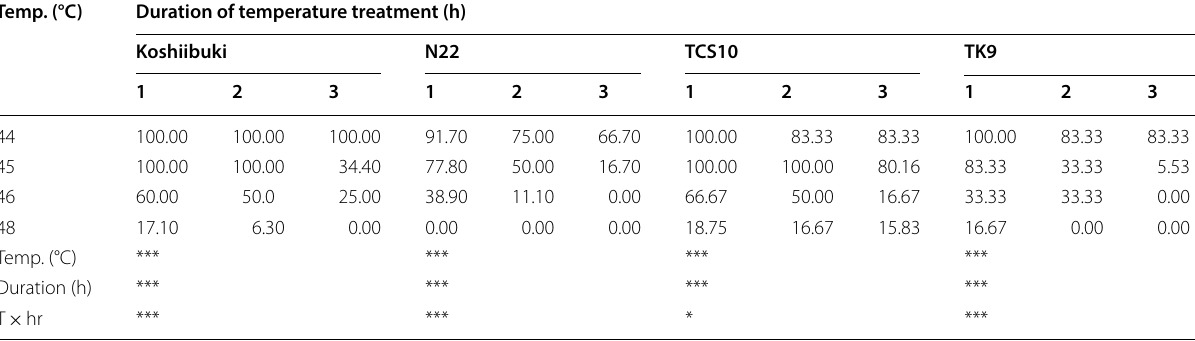
ns, *, **, *** Means not significant, significant at P ≦ 0.05, 0.01 and 0.001, respectively